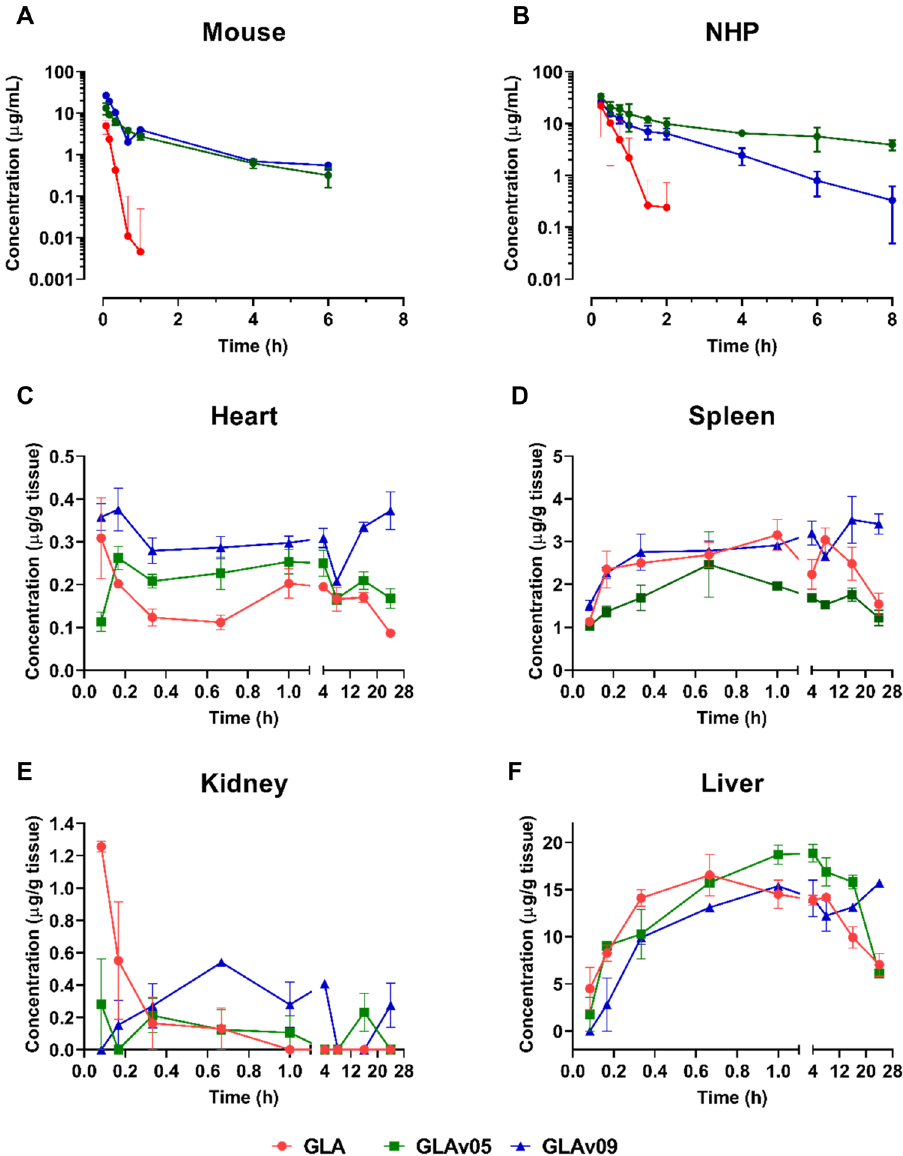
Figure 4. Pharmacokinetics and biodistribution of GLA variants. Healthy mice ( A ) and cynomolgus monkeys ( B ) were dosed at 1 mg/kg i.v. and plasma was analyzed for total active GLA. Hemizygous 2–3-month-old male Fabry mice were treated with GLA and variants at 1 mg/kg i.v. At indicated timepoints, mice were sacrificed, perfused, and tissues were harvested, processed, and tested for alpha galactosidase activity to determine active enzyme concentration: heart ( C ), spleen ( D ), kidney ( E ) and liver ( F ).